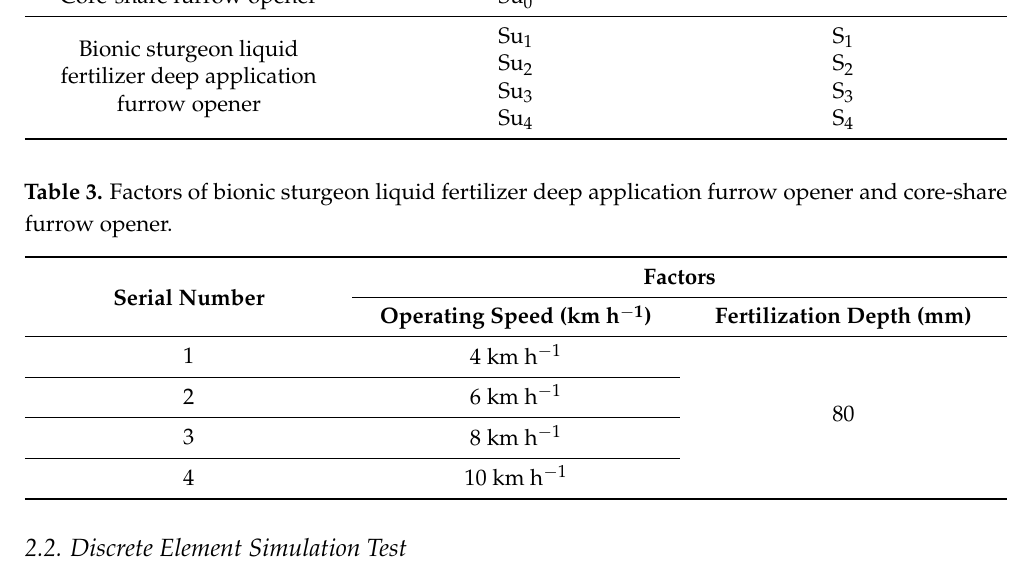
Figure 4. Structure diagram of furrow opener. ( a ) Su 0 ; ( b ) Su 1 ; ( c ) Su 2 ; ( d ) Su 3 ; ( e ) Su 4 . Table 3. Factors of bionic sturgeon liquid fertilizer deep application furrow opener and core-share Table 2. Performance evaluation table of bionic furrow opener and core-share furrow opener. furrow opener. Types of Furrow Opener Furrow Opener Code Contour Curve Core-share furrow opener